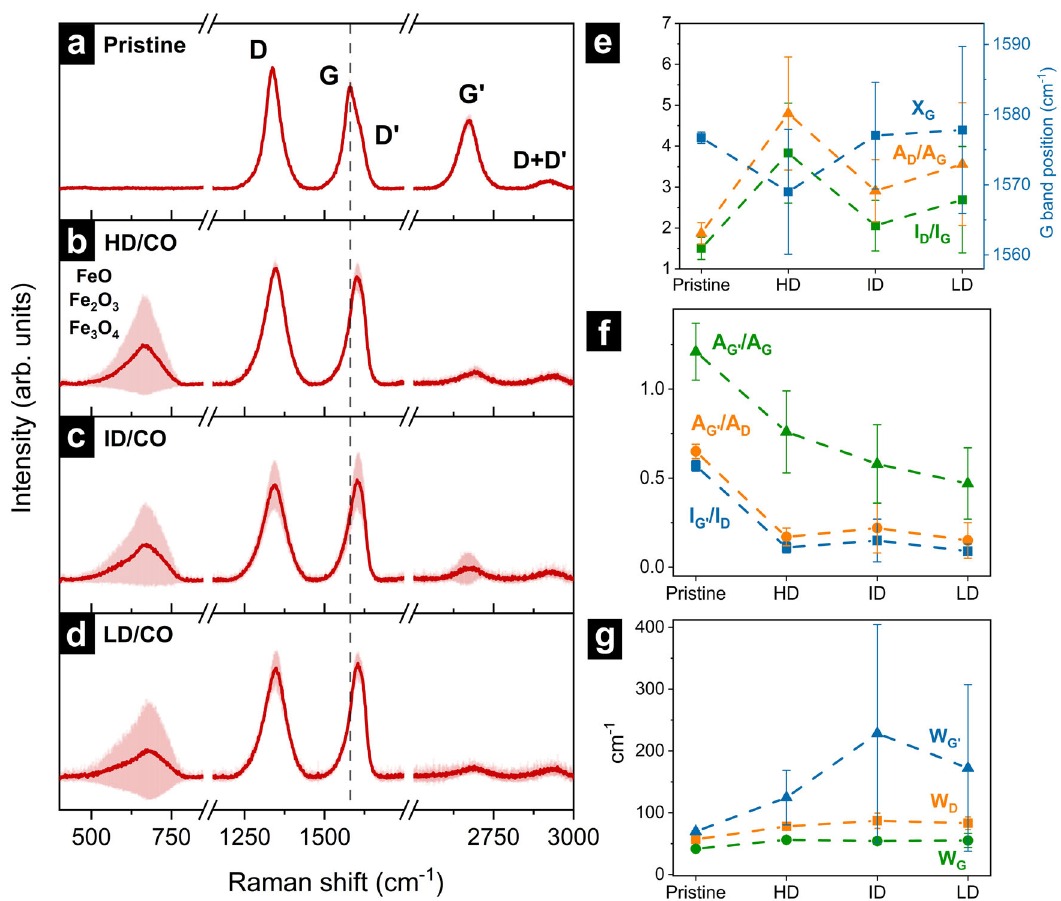
Fig. 5 Raman spectra and indicator developments of COs in pristine condition and after tribological testing. Raman spectra of a pristine COs and COs after tribological testing on b HD, c ID, and d LD surfaces, including standard deviation of spectral intensities (red area). Development of e I D /I G , A D /A G , X G f I G ’ /I D , A G ’ /A D , A G ’ /A G and g W D , W G , W G ’ with increasing structural depth (error bars represent standard deviation from three independent